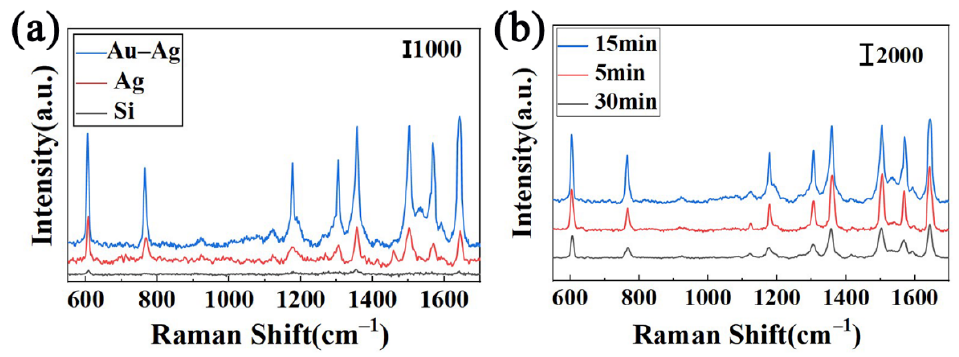
Figure 5. ( a ) SERS spectra of different substrate structures adsorbed to 10 − 9 mol/L R6G solution. ( b ) The Raman spectra of R6G on Au–Ag obtained with different reaction times.